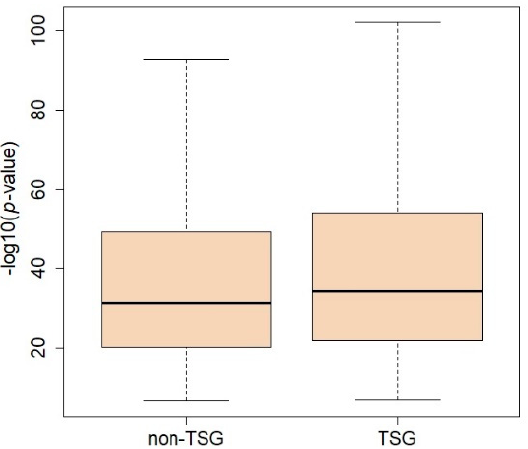
Figure 3. Comparison between p -values from differential coexpression (DCG) analysis. The tumor suppressor gene (TSG) group contains DCG results of gene pairs that have at least one TSG in the pair.